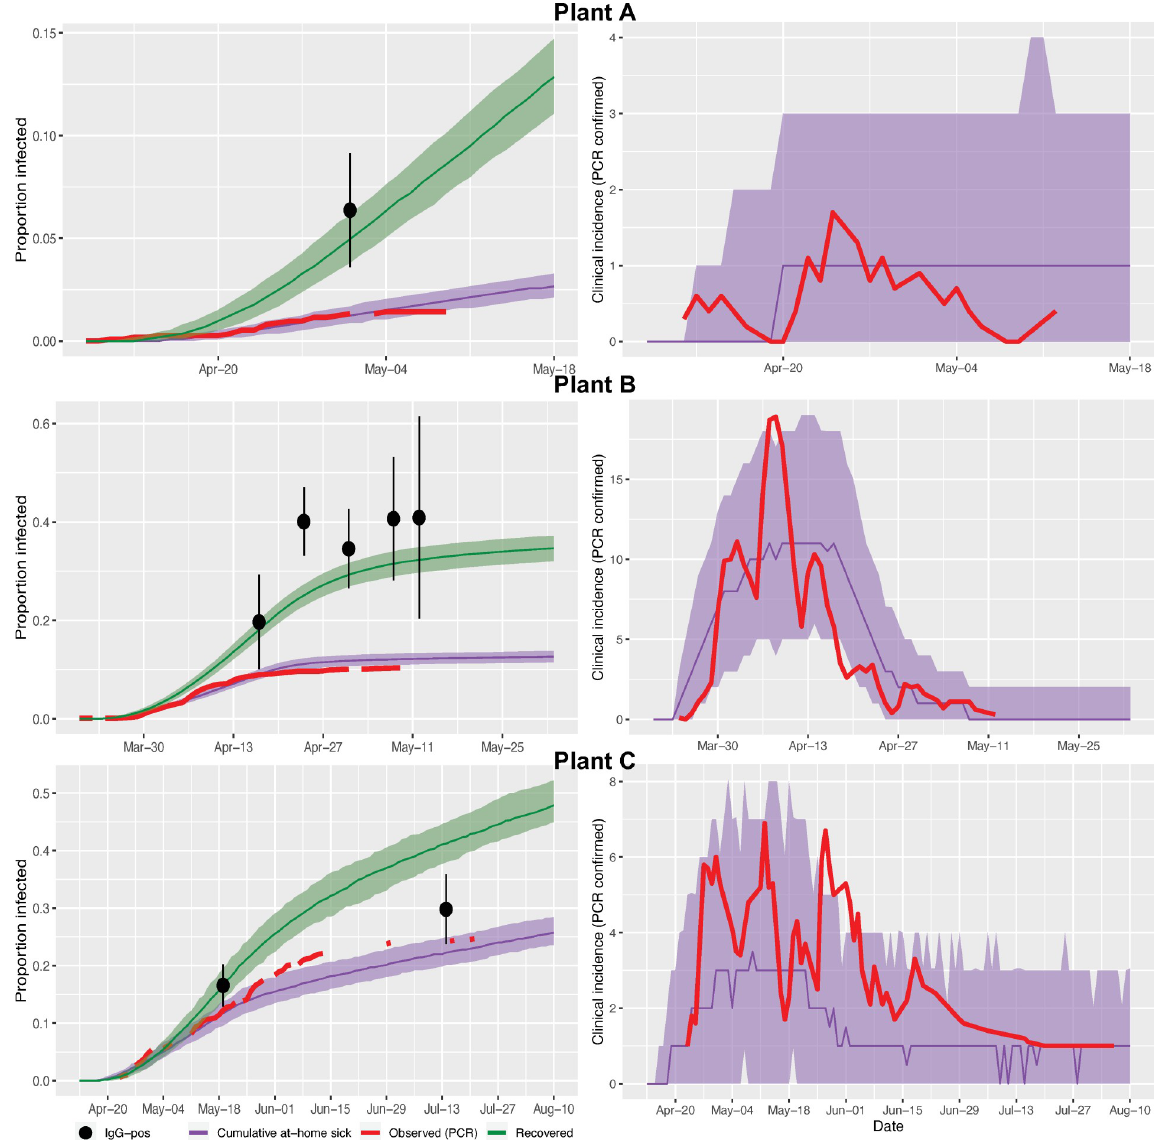
Fig 4. Output of stochastic models for plants that experienced large outbreaks (Plants B and C), showing (left) the cumulative proportion at- home sick or recovered, and (right) the smoothed daily incidence of clinical cases (4-day moving average). For both cumulative proportions and incidence plots, observed clinical case data are shown in red. Model predictions are based on the median (colored lines) and 50% prediction interval (shaded area) summarized from 1000 runs of the stochastic model. Black dots indicate the observed proportion IgG-positive, with whiskers showing standard error of